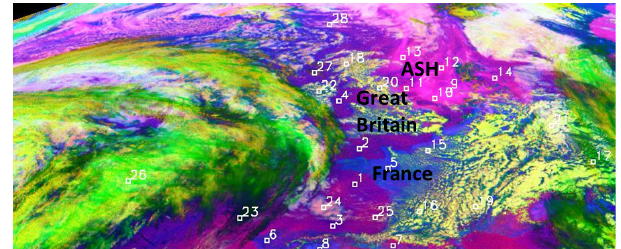
Fig. 1. SEVIRI RGB image (see the text for details) on 17 May 2010 at 13:30UTC over Europe and the Atlantic Ocean; the 28 boxes in- dicate the location of extracted samples for various scenes of clear- sky water (boxes 1–4), clear-sky land (boxes 4–8), ash over water (boxes 9–14), and cloud (boxes